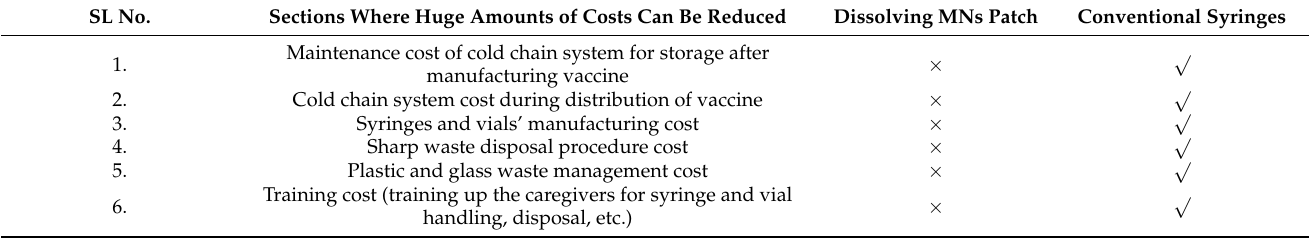
Table 8. Comparison between DMNs and conventional syringes regarding cost